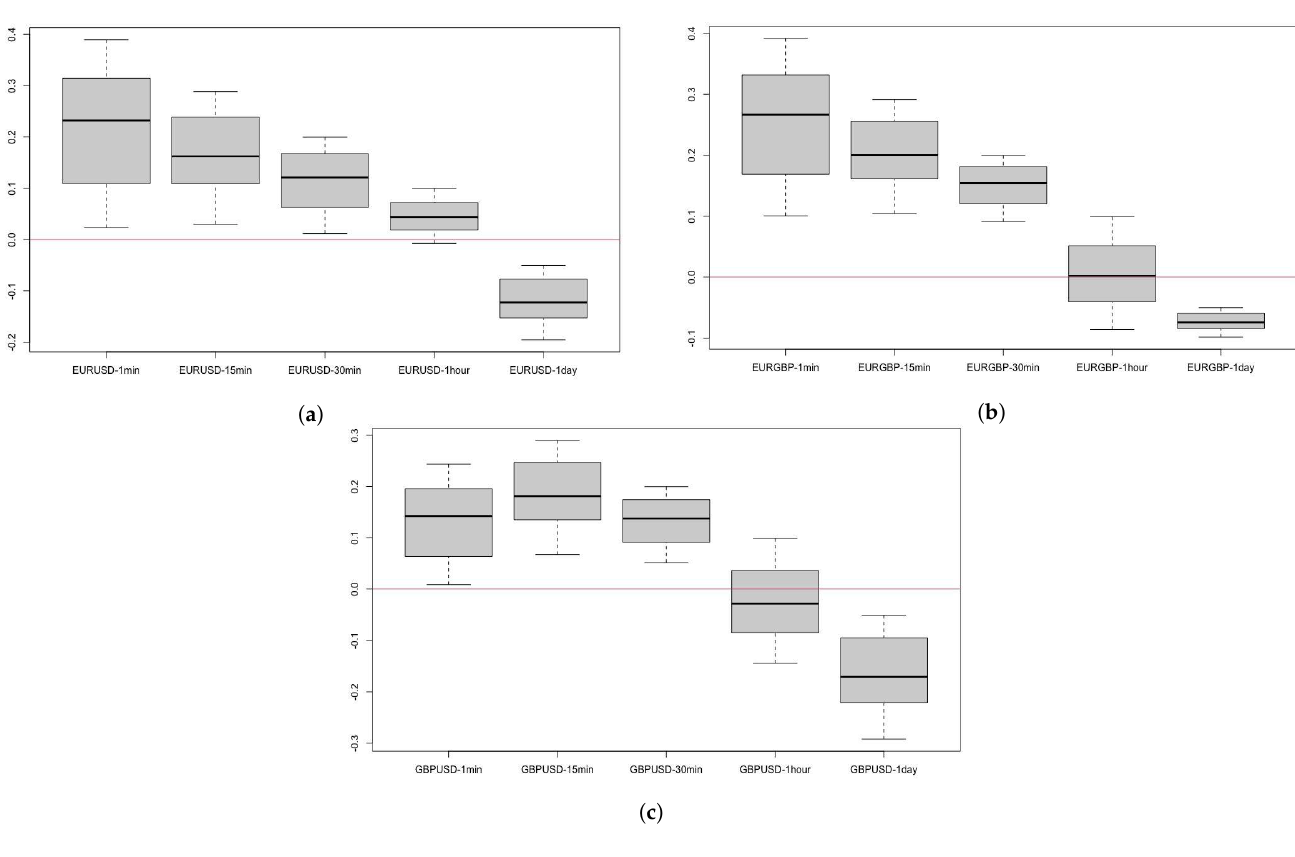
Figure 7. Results pertaining to the returns time series from ( a ) EURUSD, ( b ) EURGBP, and ( c ) GB- PUSD for each time frequency considered over the last 15 years are shown for the bootstrap blocking method. The number of bootstrap iterations is B =